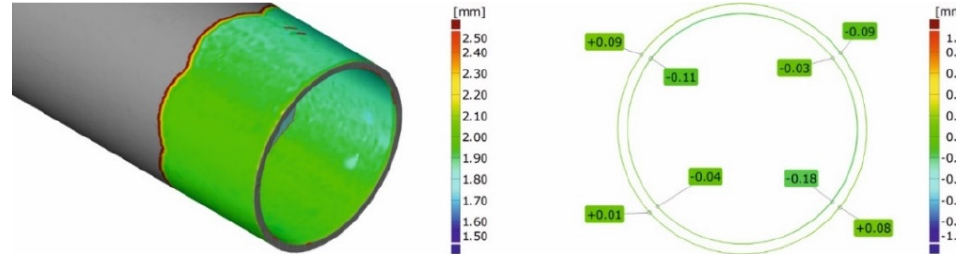
Figure 18. Results of optical scanning of the tubes of Ø50 × 2 mm from 6082 alloy: coloured maps of deviations for 6082 alloy using a 4-hole die (wall thickness on the left and roundness/circularity deviations on the right).